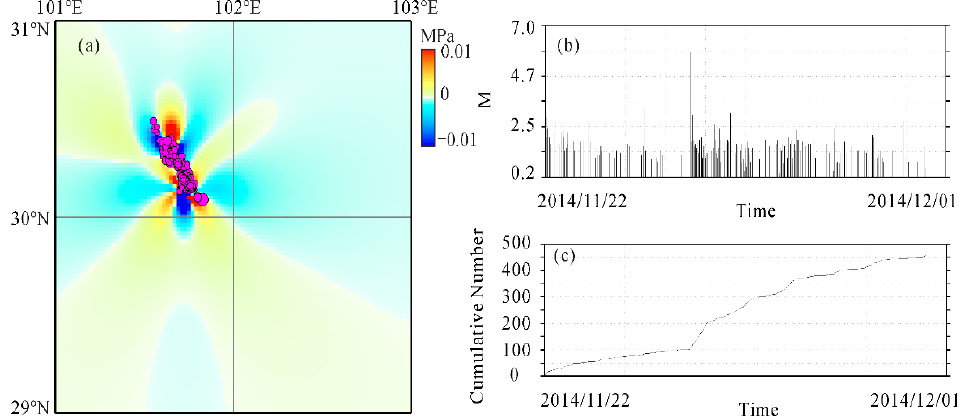
Figure 6. ( a ) Distribution of coseismic Coulomb failure stress changes caused by the 2014 Ms 6.3 and Ms 5.8 Kangding double earthquakes at the depth of the mainshock and aftershocks (Yi et al. [74]). ( b ) Temporal distribution of aftershock magnitudes. ( c ) Cumulative number of aftershocks over time.